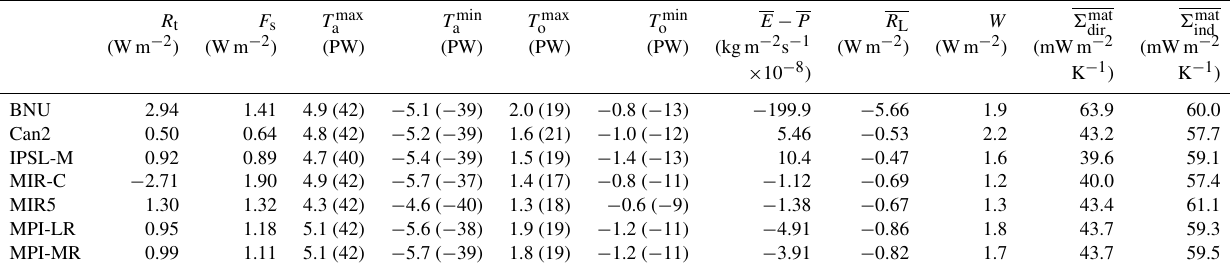
Table 3. Same as in Table 2 for the period 1970–2000 of the historical runs.